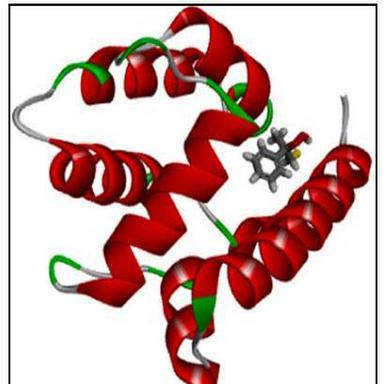
Location of the best docked poses of the ligands homoguaiacol, apocynin, guaiacylacetone, homovanillyl alcohol and 4-ethylguaiacol in the mouse eugenol olfactory receptor estimated via a docking calculation by iGEMDOCK.